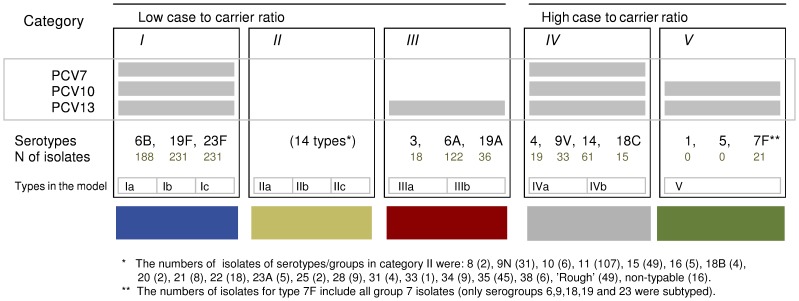
Stratification of pneumococcal serotypes.Serotypes are stratified into 5 categories, based on their inclusion in different PCV formulations (PCV7, PCV10 and PCV13) and their case-to-carrier ratios. The number (N) of isolates refers to the distribution of serotypes in children <2 years of age [25]. In the model, each category is subdivided into a given number of individual model types.